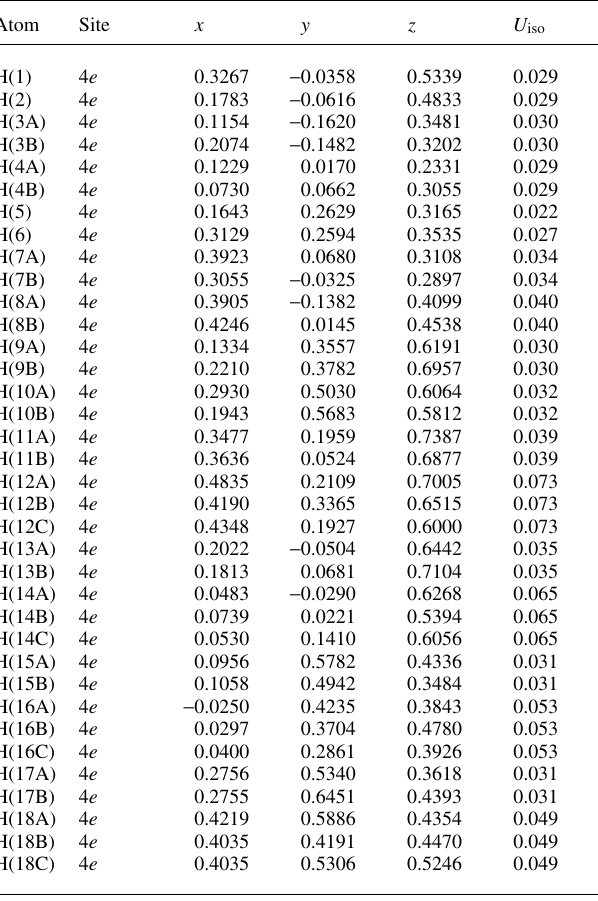
Table 2. Atomic coordinates and displacement parameters (in Å 2 )